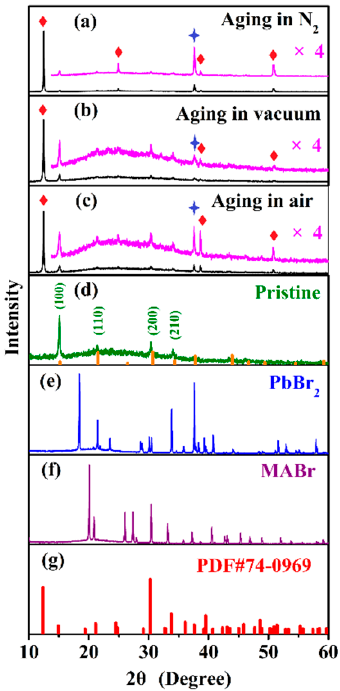
Figure 3. XRD patterns of MBNCs-PVDF: ( a ) After aging in N 2 ; ( b ) after aging in vacuum; ( c ) after aging in an air atmosphere; and ( d ) pristine sample. For reference, ( e ) and ( f ) provide XRD patterns of PbBr 2 and CH 3 NH 3 Br (MABr); and ( g ) provides a standard XRD pattern of NH 4 Pb 2 Br 5 (PDF#74-0969). The standard patterns of MAPbBr 3 (PDF#54-0752) are provided at the bottom of ( d ). Diamonds and stars indicate di ff raction peaks of NH 4 Pb 2 Br 5 and PbBr 2 , respectively. The temperature and 368-nm UV light irradiation density during aging are 323 K and 5.6 mW / cm 2 .